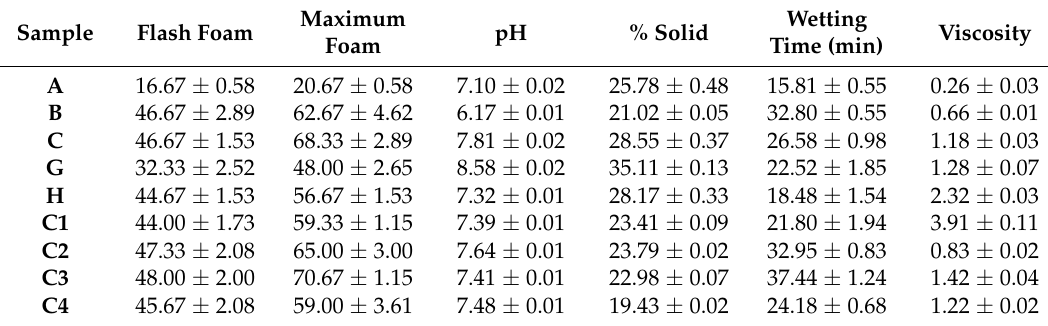
Table 5. Characterization of formulated and marketed